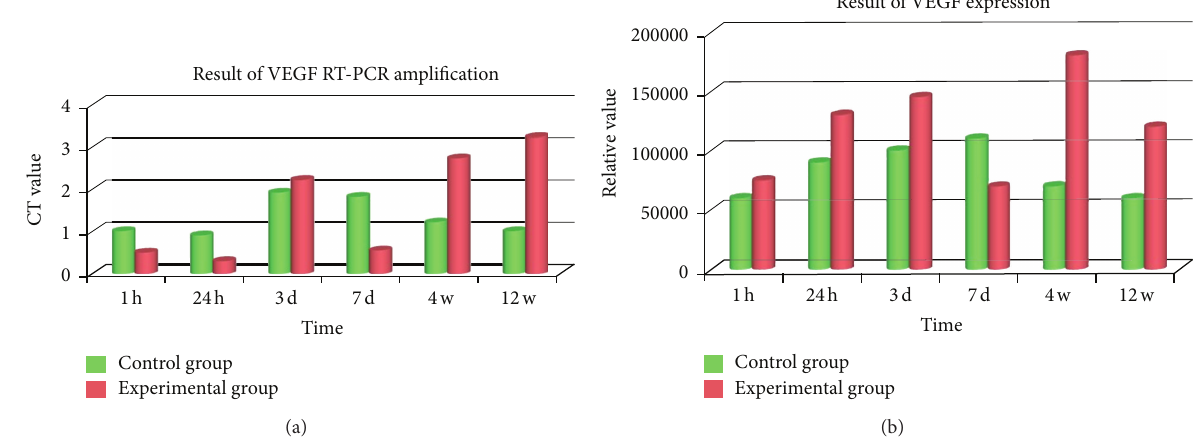
Figure 4: (a) VEGF mRNA expression was lower in 1h and 24 h ( 𝑃 < 0.05 ), whereas the expression was highly increased in 3d but decreased in 7 d. Then, it experienced a persistent augment from 4w to 12w ( 𝑃 < 0.001 ). (b) VEGF protein expression was increased in 1h, 24 h, and 3d; also it was decreased in 7 d. After that the expression was transparently elevated and higher than that of control ( 𝑃 < 0.05 ).